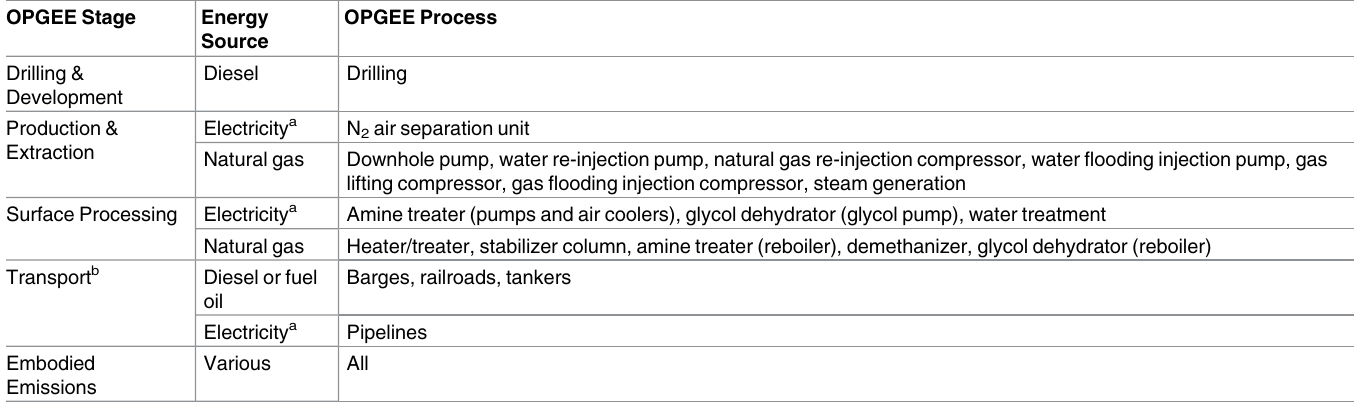
Table 1. The energy sources used in the processesassociatedwith each OPGEE upstream stage. Data from Brandt et al.